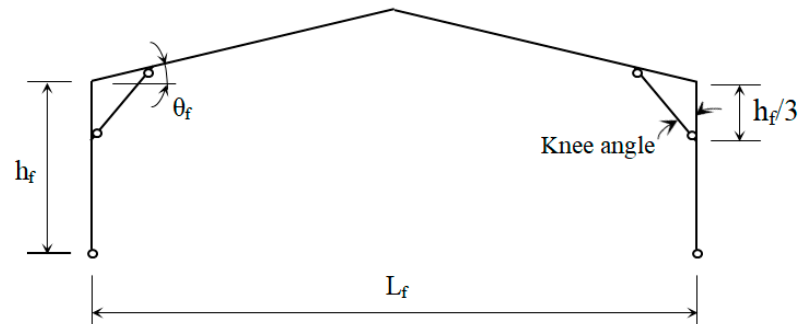
Figure 5. General diagram of knee brace joint configuration.